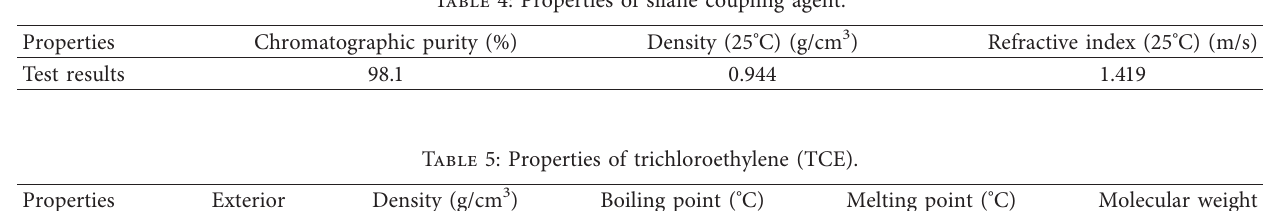
Table 4: Properties of silane coupling agent.